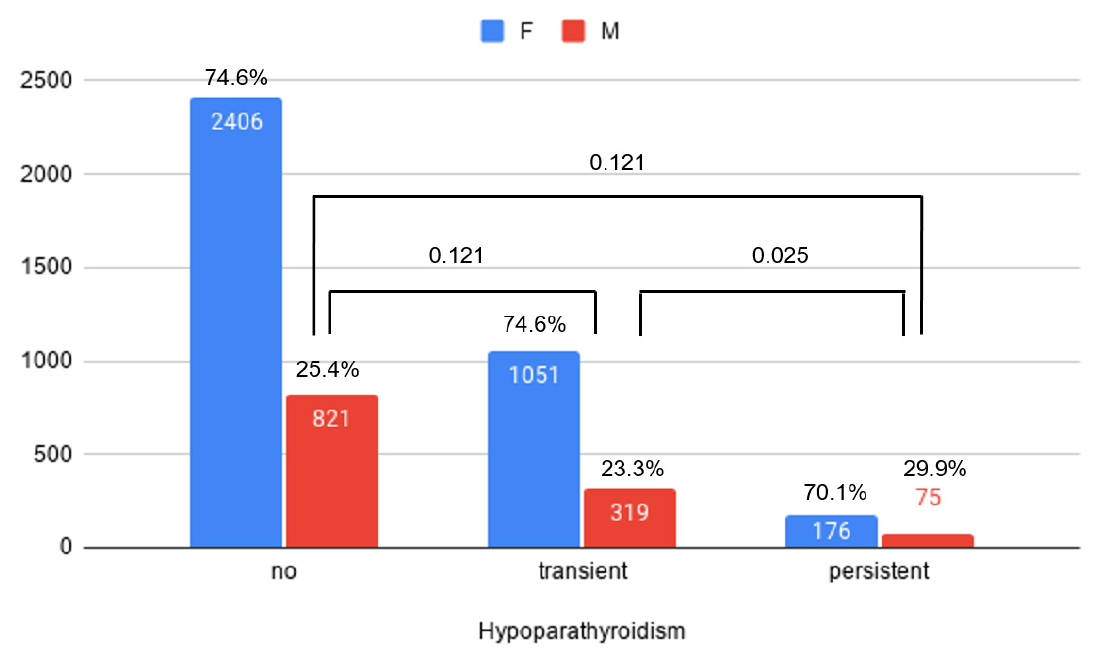
Figure 2. Post-operative hypoparathyroidism status according to sex. F: Female; M: male.